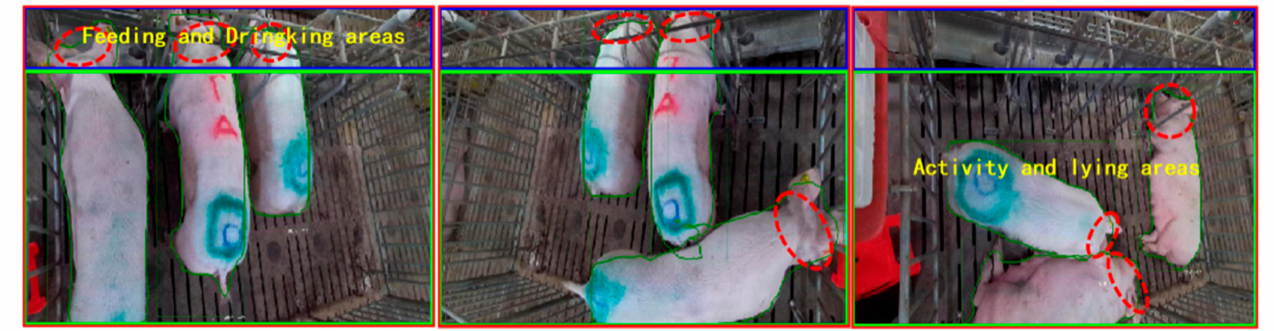
Figure 12. Image segmentation of sows with behaviors and different areas (The blue box: drinking and feeding areas; The green box: activity and lying areas).